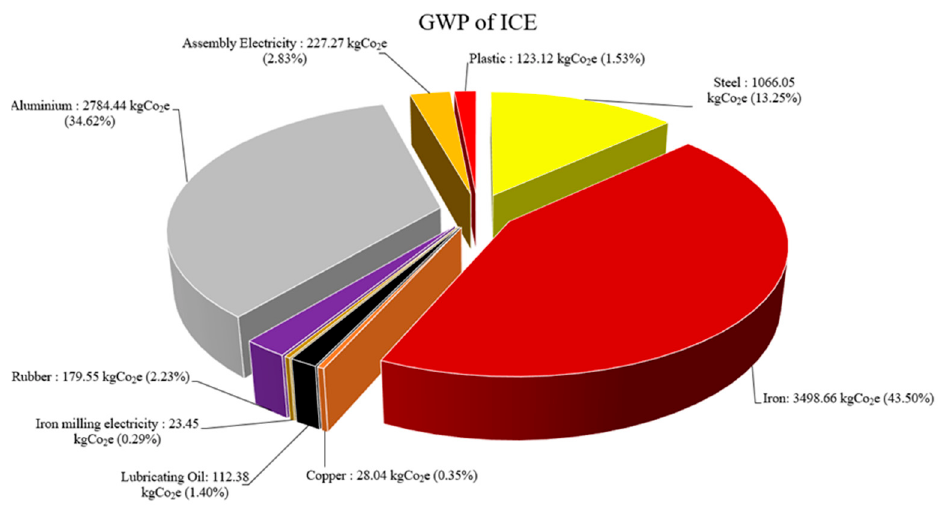
Figure 7. GWP contributions for ICE.